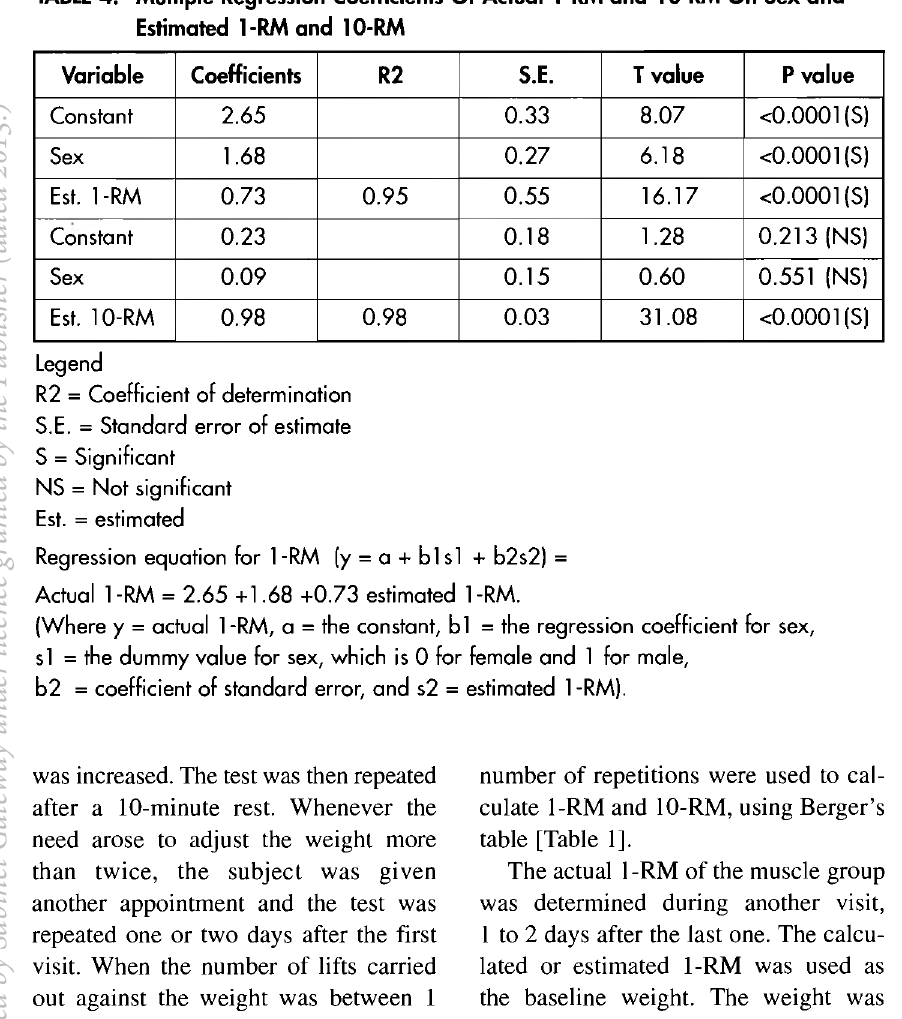
TABLE 4. Multiple Regression Coefficients Of Actual 1 -RM and 10-RM On Sex